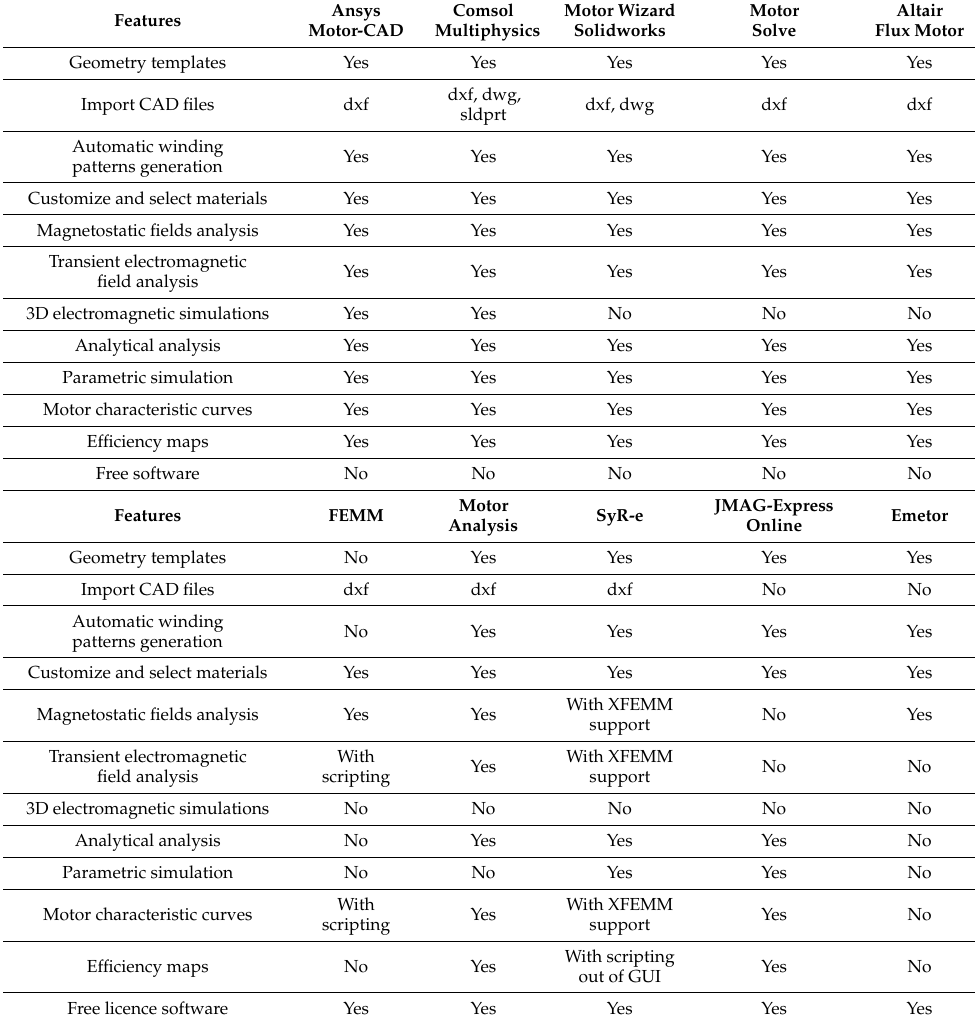
Table 1. The comparison of motor design